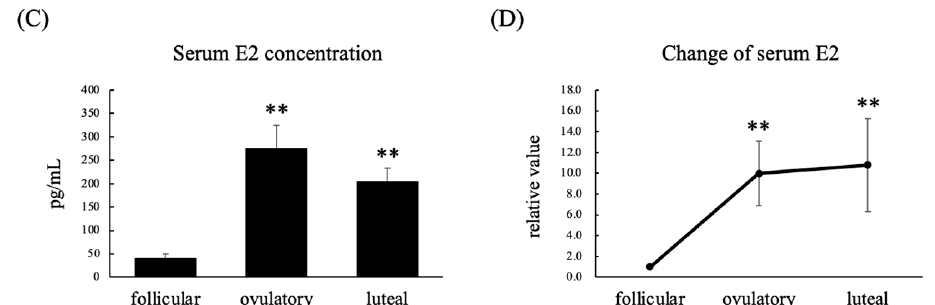
Figure 1. Serum OT concentration ( A ), relative serum OT concentration ( B ), serum E2 concentration ( C ), and relative serum E2 concentration ( D ) in the follicular, ovulatory, and luteal phases in women with regular menstrual cycles. The relative values for each phase were calculated by dividing the observed levels by those seen in the follicular phase. Data are expressed as the mean ± standard error. n = 9 per group; ** p < 0.01 vs. follicular phase.